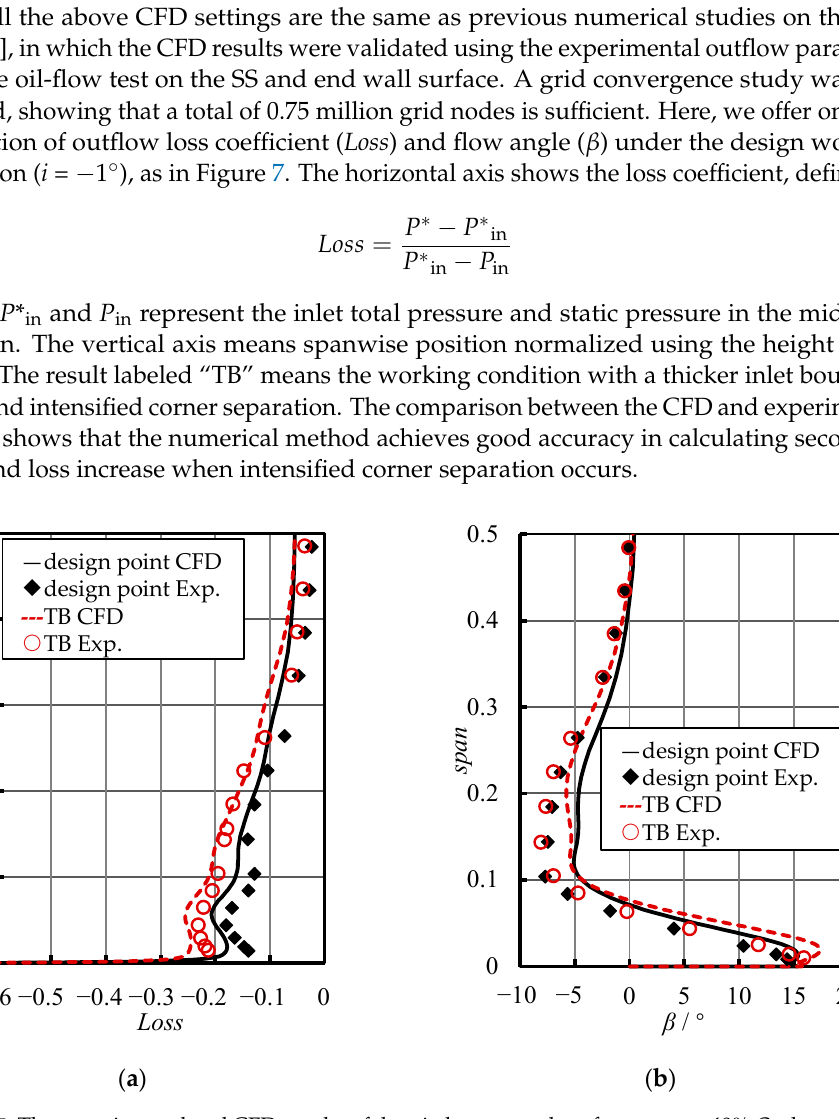
Table 3. The design parameter of the end wall contouring cases.